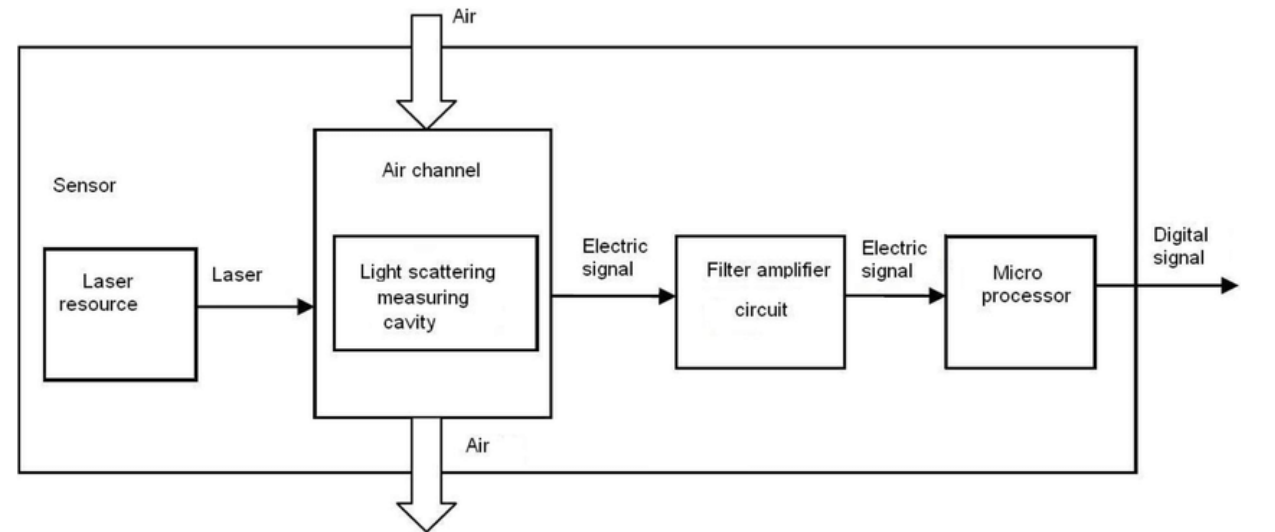
Figure 5. Functional block diagram of the optical PM sensor [43].